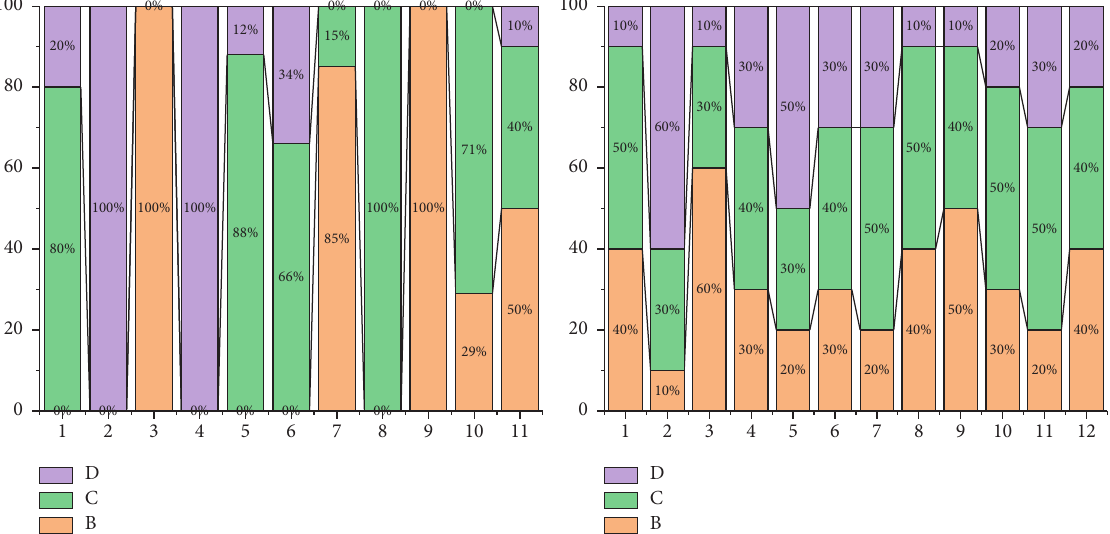
Figure 3: Hierarchical distribution of qualitative indicators.